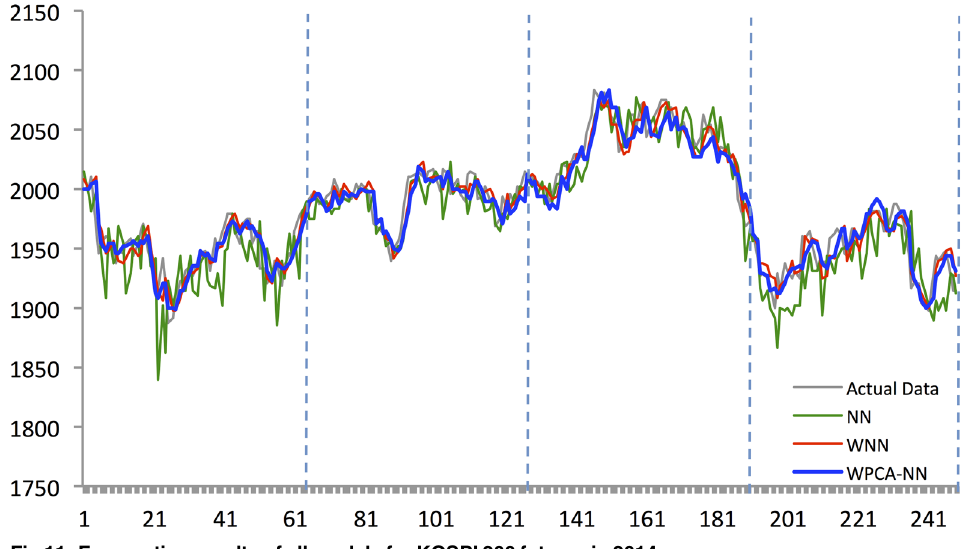
Fig 11. Forecasting results of all models for KOSPI 200 futures in 2014.